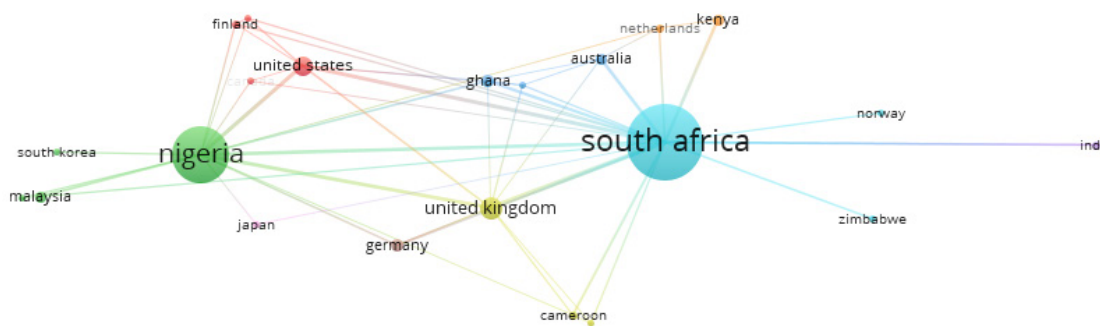
Figure 3. International collaboration based on co-authorship by countries